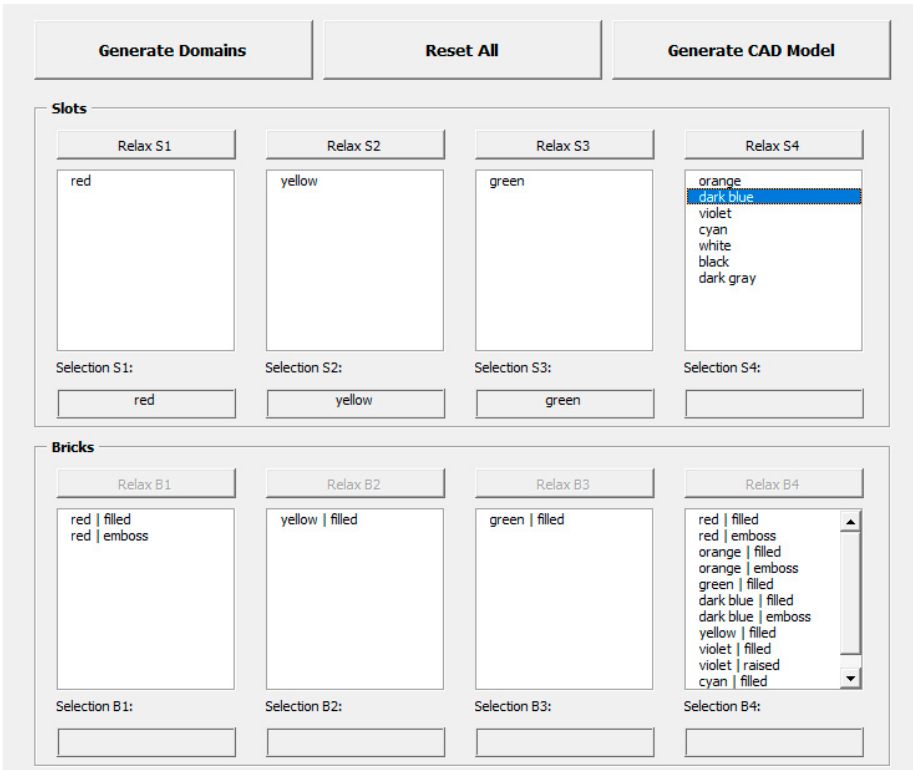
Figure 9. User form for sorting box configuration.